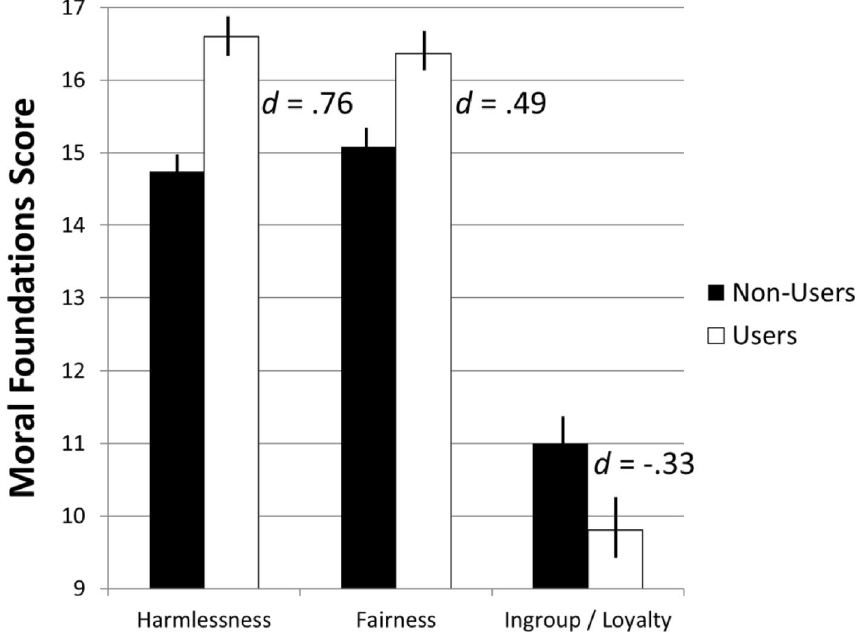
Figure 3. Group differences in moral foundation principles of harmlessness, fairness, and ingroup loyalty. Note. The harmlessness scores ranged from 6 to 20, fairness scores 8 to 20, and ingroup/loyalty scores 0 to 19.